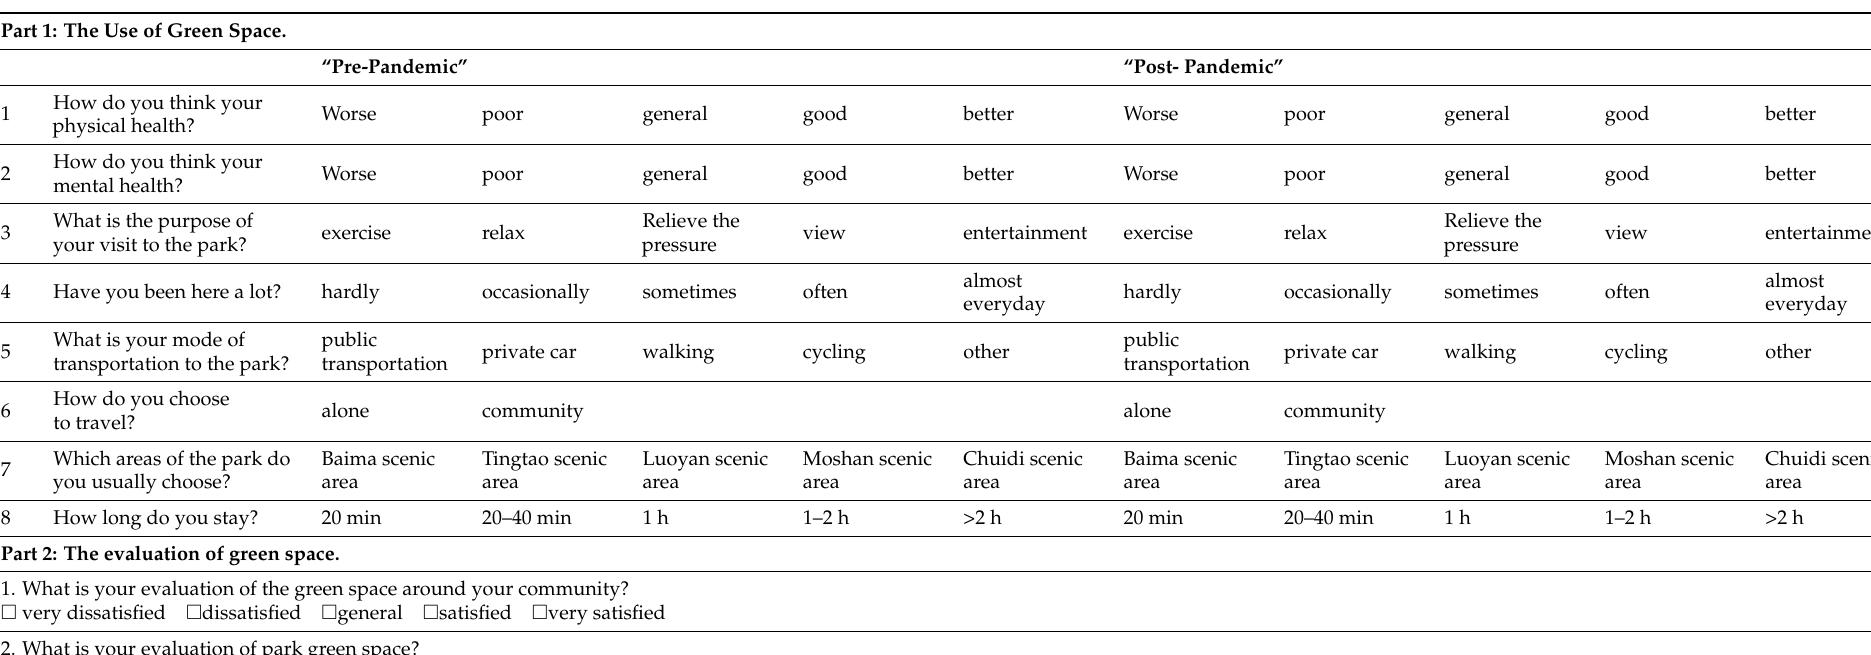
Table 1. Measurement of residents’ physical and mental health and their attitude and behavior toward green